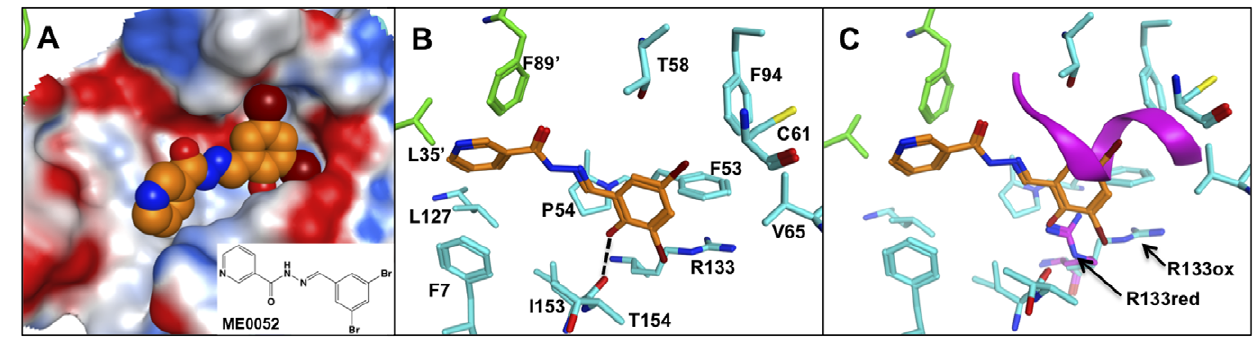
Figure 7. Model for salicylidene acylhyrazide ME0052 binding mode to oxidised yp Tpx crystal structure. (A) Binding mode for lowest docked energy ME0052 (atoms represented as CPK orange for carbon, blue for nitrogen and red for bromines) and electrostatic surface for the protein binding site (Connolly surface, sphere radius=1.4 A˚). ChemDraw representation for the ME0052 inhibitor is inset. (B) Detailed view of ME0052 binding mode (stick representation). Oxidised yp Tpx residues with atom contacts within 3.5 A˚ of ME0052 inhibitor are shown (cyan). Residues F89 9 and L35 9 are contributed by the neighbouring monomer (green). A hydrogen bond (dashed line) is formed between inhibitor and I153 carbonyl. (C) ME0052 binding mode from (B) with reduced yp Tpx (protein backbone magenta ribbon) superposed on oxidised yp Tpx; shown are a 1 helix and the R133 side chain of the reduced form partially occluding the binding pocket of oxidised form.